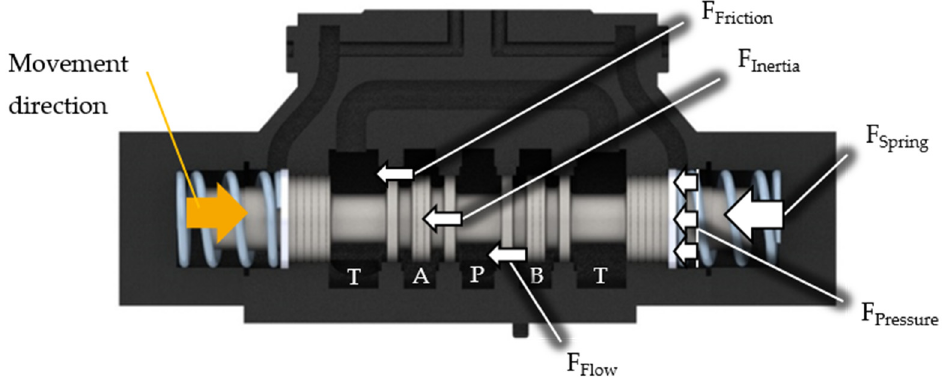
Figure 2. Forces at the spool in accordance with reference [13–15].